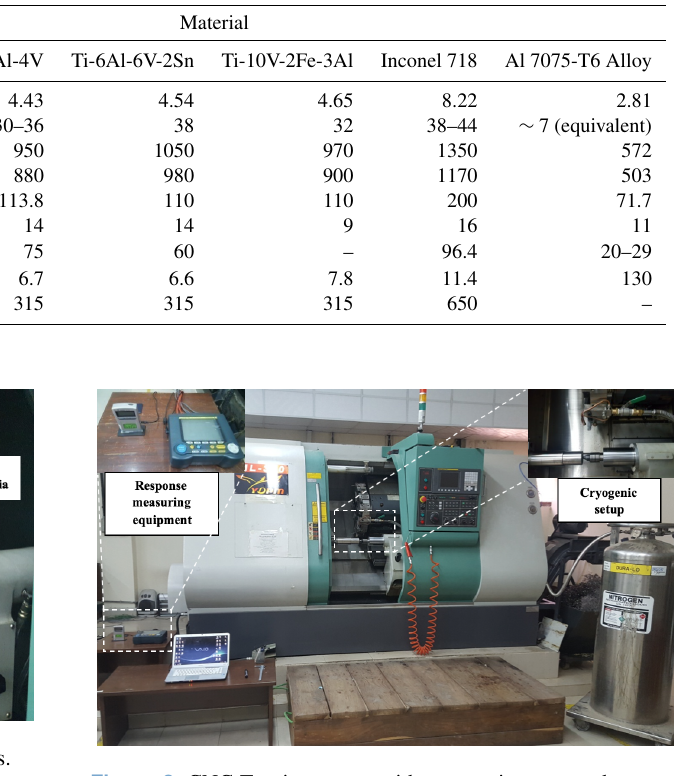
Figure 2. CNC Turning centre with cryogenic setup and response measuring